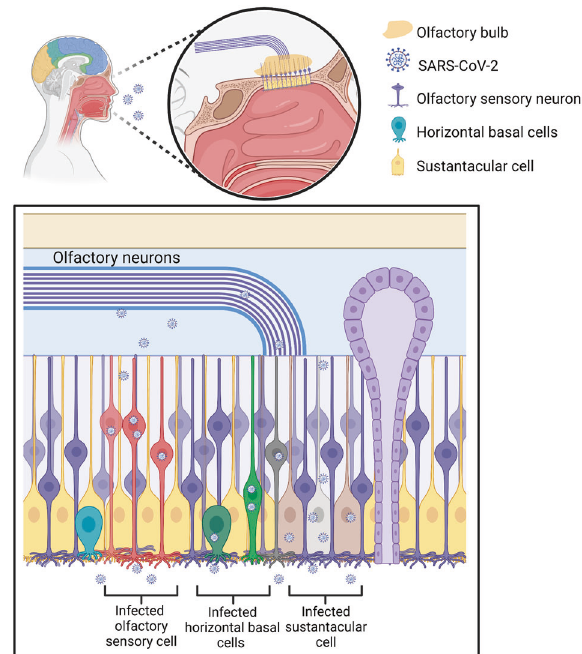
Fig. 2 SARS-CoV-2 may invade the brain through the olfactory nerve. SARS-CoV-2 infects the olfactory epithelium via the ACE2 receptor. The olfactory epithelium surrounds horizontal basal cells with ACE2 receptor. Human horizontal basal cells express ACE2, suggesting they can be infected by SARS-CoV-2. Horizontal basal cells can further mature into olfactory neurons. We propose that infected horizontal basal cells can mature into SARS-CoV-2-infected olfactory neurons. These infected olfactory neurons share a synaptic connection with neurons in the olfactory bulb (OB). This may allow for viral spread from the periphery into the CNS. The OB has many connections throughout the brain. This allows for rapid viral transit to many areas of the